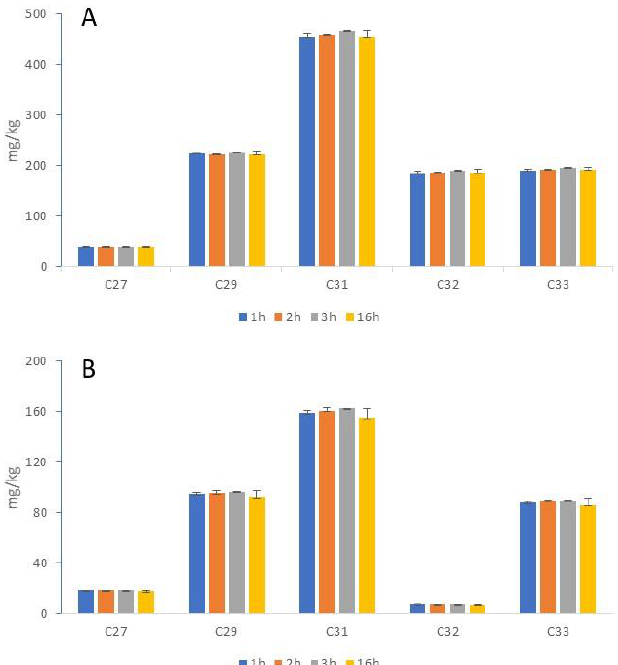
Figure 1. Effect of saponification time on the concentration of the major n -alkanes (C27–C33) in faeces ( A ) and herbage ( B ) samples. Saponification was performed in 5 mL Wheaton vials with 60 mg sample and 2 mL 1 M ethanolic KOH at 90 °C. Each column is the mean of two replicates and error bars are standard deviations (SD). Note: no significant difference was found for any n -alkane across the 4 incubation times (statistical symbols omitted).